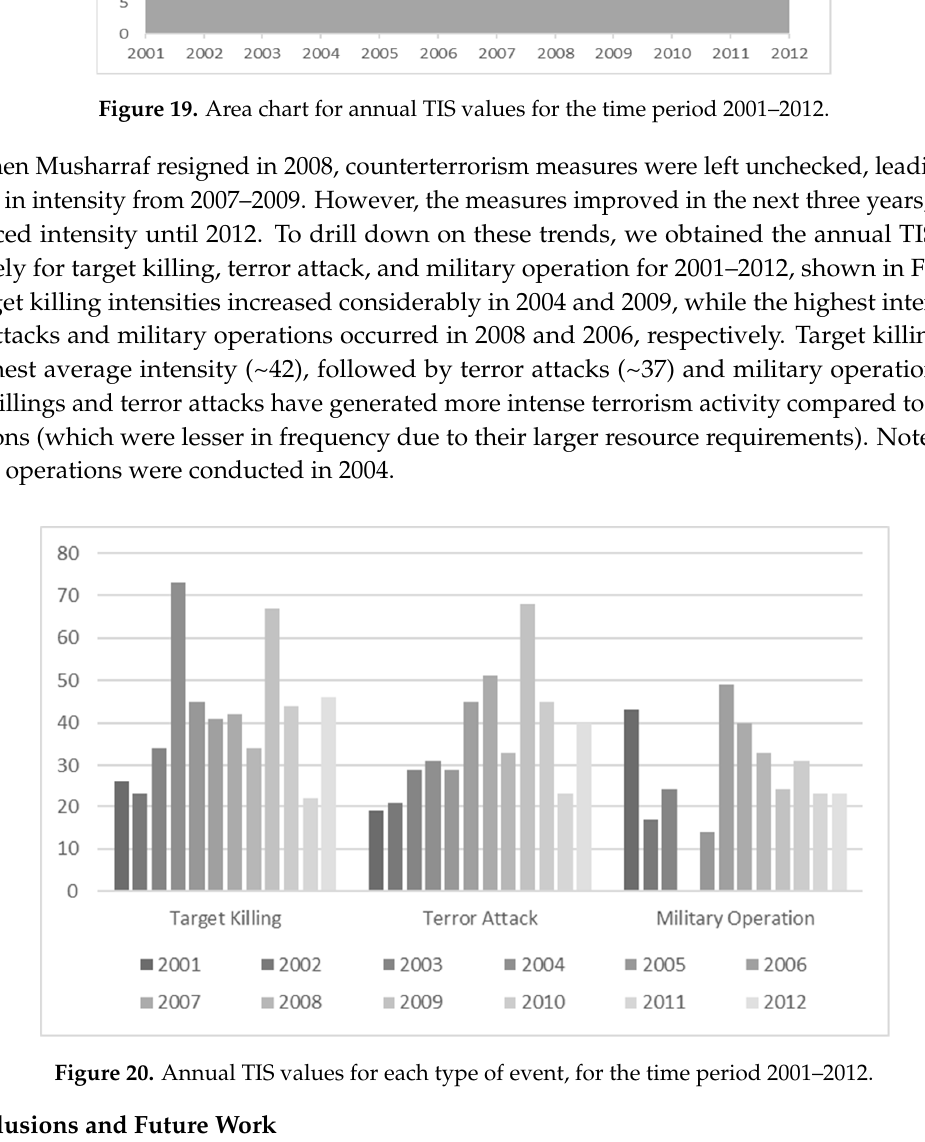
Figure 19. Area chart for annual TIS values for the time period 2001–2012.